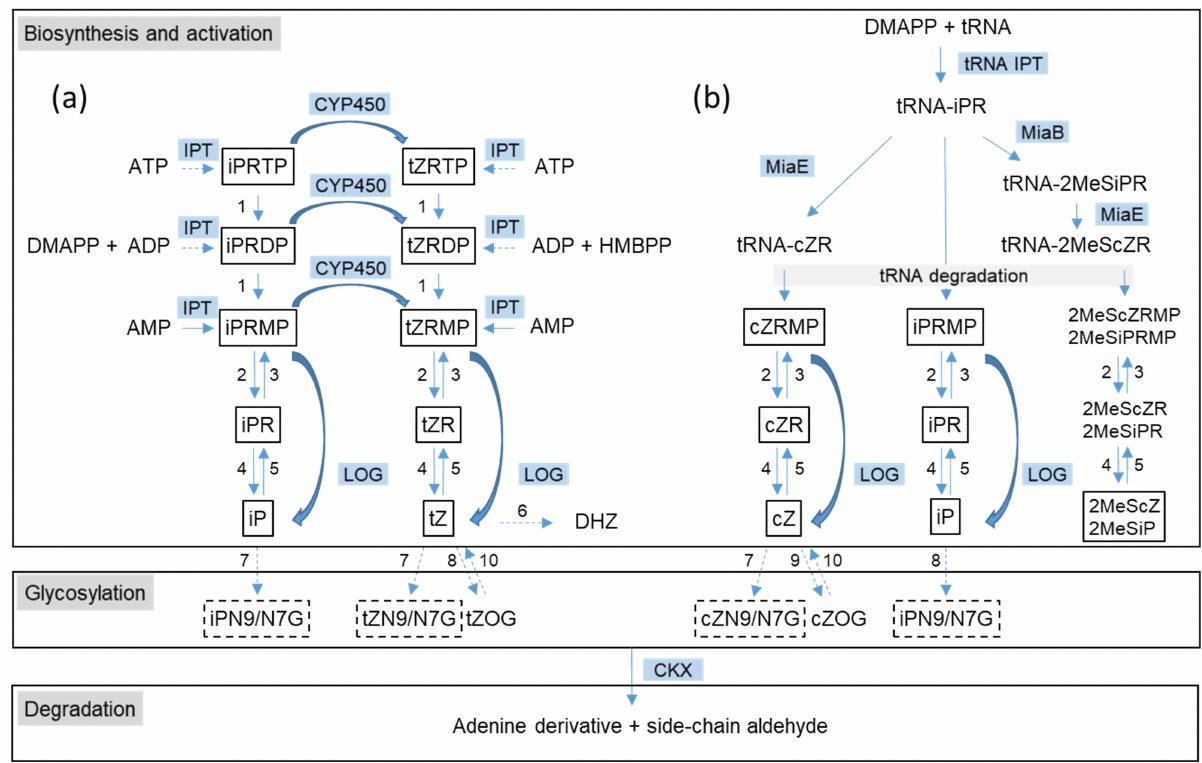
Figure 1. An overview of cytokinin (CK) metabolism as identified in plants and bacteria. ( a ) De novo CK biosynthesis pathway; ( b ) tRNA-dependent CK biosynthesis pathway. The key enzymes involved in CK biosynthesis and activation are isopentenyl transferase (IPT), cytochrome P450 monooxygenase (CYP450), CK phosphoribohydrolase “Lonely guy” (LOG), tRNA isopentenyl transferase (tRNA IPT), 2-methylthio-N6-dimethylallyladenosine synthase (MiaB), and tRNA 2-methylthio-N6-isopentenyl-adenosine(37) hydroxylase (MiaE). Other unspecific enzymes may be involved: phosphatase (1), 5 (cid:48) -ribonucleotide phosphohydrolase (2), adenosine kinase (3), adenosine nucleosidase (4), and purine nucleoside phosphorylase (5). tZ can be converted to dihydrozeatin (DHZ) by zeatin reductase (6). Deactivation of CKs is performed by CK N -glucosyltransferase (7), tZ- O - β - D -glucosyltransferase (8) and cZ- O - β - D -glucosyltransferase (9). O -glucosyl moiety can be removed by β -glucosidase (10). Irreversible degradation of CKs is catalyzed by CK dehydrogenase (CKX). Confirmed substrates of CKX are shown in boxes; only CK- N 9 glucosides but not CK-N7 glucosides are CKX substrates (depicted by dashed boxes). CK abbreviations: iP, isopentenyladenine; iPR, isopentenyladenosine; iPRMP, iPRDP, iPRTP, isopentenyladenine riboside 5 (cid:48) -mono-, di-, triphosphate; tZ, trans -zeatin; cZ, cis -zeatin; ZR, zeatin riboside; ZRMP, ZRDP, ZRTP, zeatin riboside 5 (cid:48) -mono-, di-, triphosphate; 2MeSiPR, 2-methylthio isopentenyladenosine; 2MeScZR, 2-methylthio- cis - zeatin riboside; 2MeSiPRMP, 2-methylthio isopentenyladenine riboside 5 (cid:48) -monophosphate; 2MeScZRMP, 2-methylthio- cis -zeatin riboside 5 (cid:48) -monophosphate; iPN9/N7G, isopentenyladenine N 9- or N 7-glucoside; ZN9/N7G, zeatin N 9- or N 7-glucoside; ZOG, zeatin O -glucoside. The pathways involving the enzymes not described in bacteria are shown by dashed arrows. There is no experimental evidence for the presence of 2MeSCK riboside 5 (cid:48) -monophosphates in plant or bacterial samples, and their conversion to corresponding free bases by LOG has not been